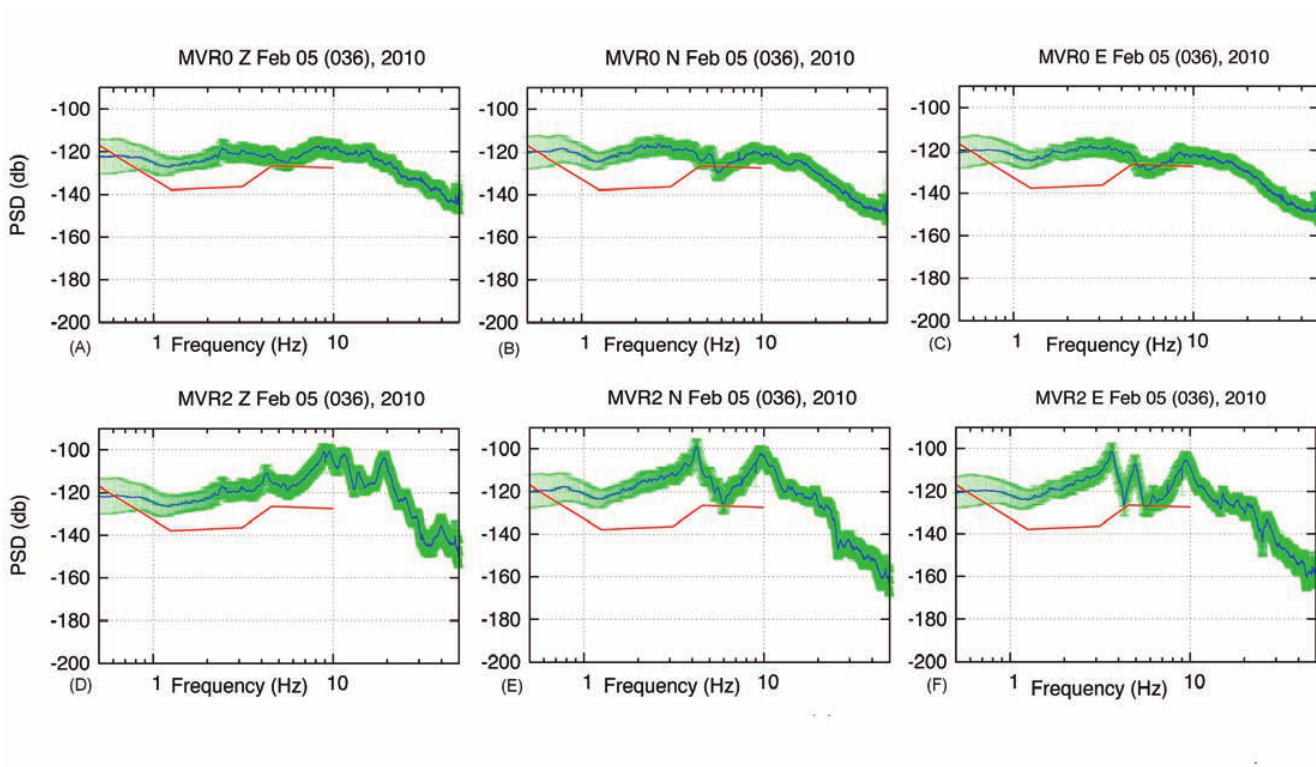
Figure 8. PSD curves for the ground velocity as a function of the frequency for external station MRV0 (A EW, B NS and C vertical component) and internal station MRV2 (D EW, E NS and F vertical component). Red lines, high-level noise Peterson curve, which represents a worldwide reference for the noise. Green bars represent standard deviations of PSD curves. The PSD curves from the external station MVR0 are generally flat, while those from the internal station MVR2 show several peaks in the frequency range of 1 Hz to 20 Hz, with an increased level of 20 db.